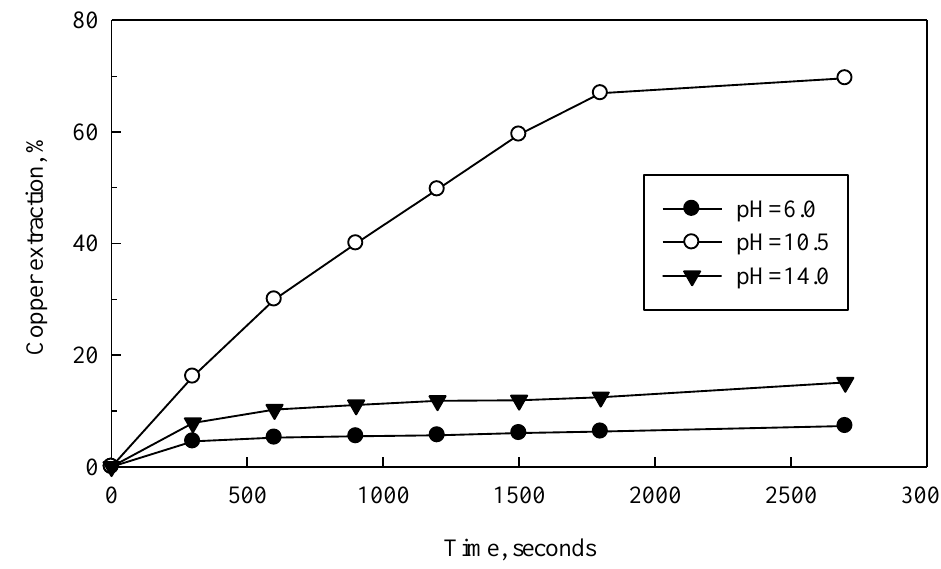
Figure 3. E ff ect of the pH of the leaching solution on copper extraction. Working conditions—[NH 4 OH] Figure 3. Effect of the pH of the leaching solution on copper extraction. Working = 0.7 mol / dm 3 , PS = 64 µ m, Agitation = 500 rpm, ratio = 1000 / conditions—[NH 4 OH] = 0.7 mol/dm 3 , PS = 64  m, Agitation = 500 rpm, ratio = 1000/1.